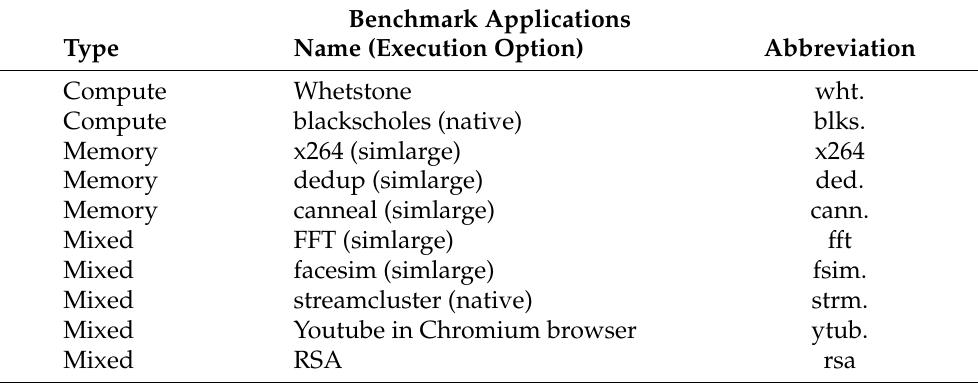
Table 1. Abbreviations of different types of benchmark